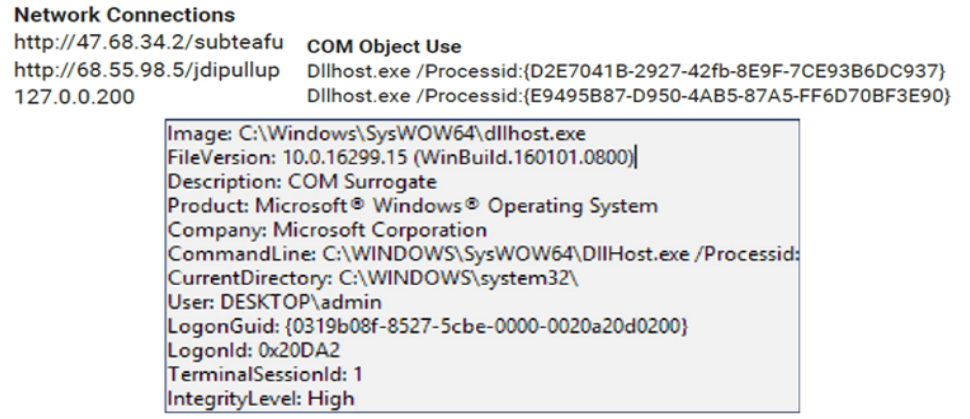
Figure 2. Threat intelligence report IoCs.